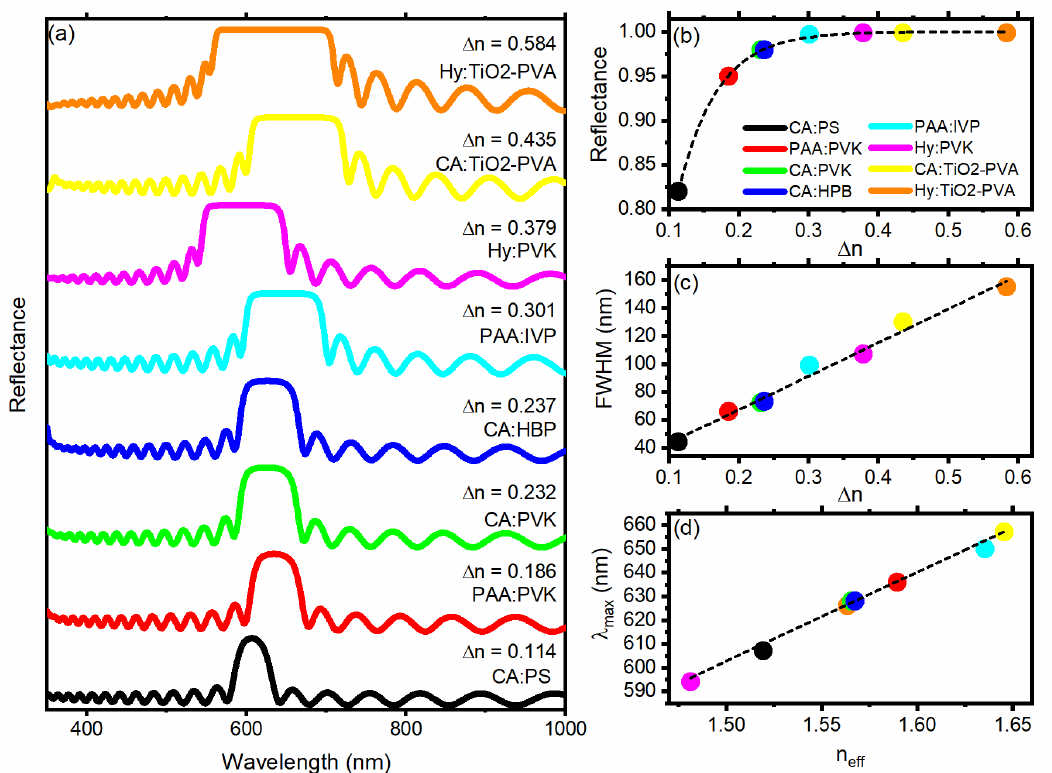
Figure 3. ( a ) Reflectance spectra calculated for DBRs made of 15.5 bilayers of low and high refractive index media with thicknesses of d L = 120 nm and d H = 80 nm employing the refractive